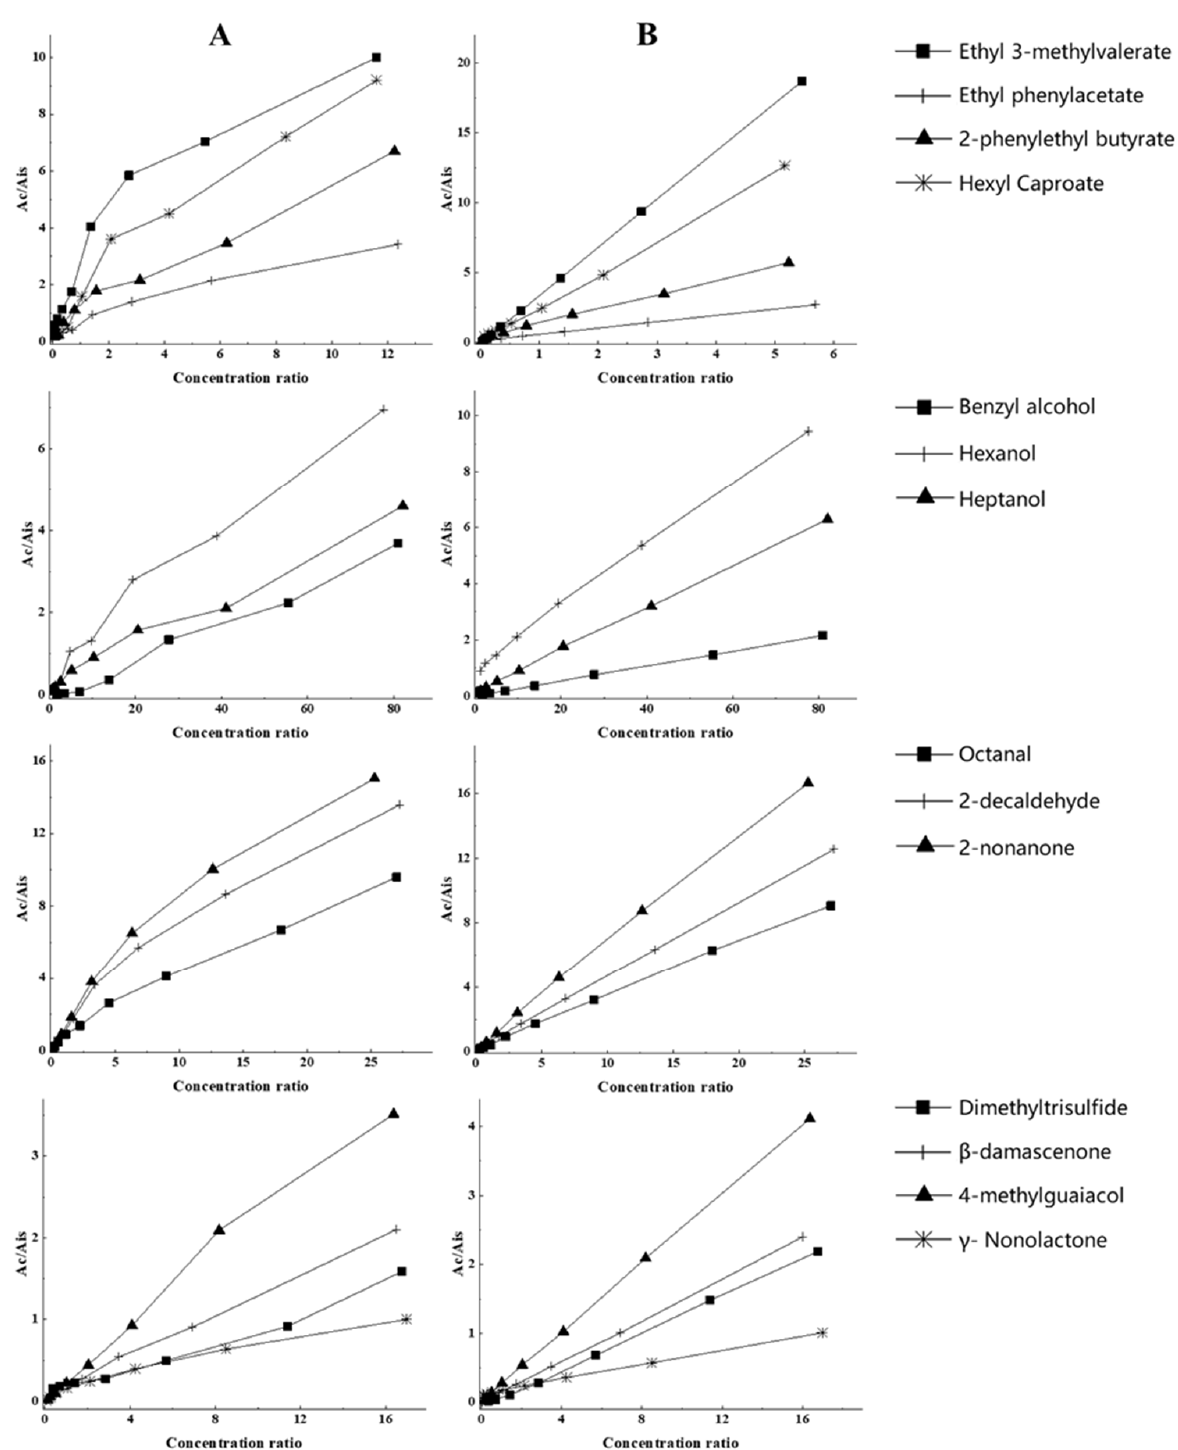
Figure 4. Standard curves of different chemical classes of compounds in the quantitative analytes: ( A ) SS and ( B ) SS+HCV.